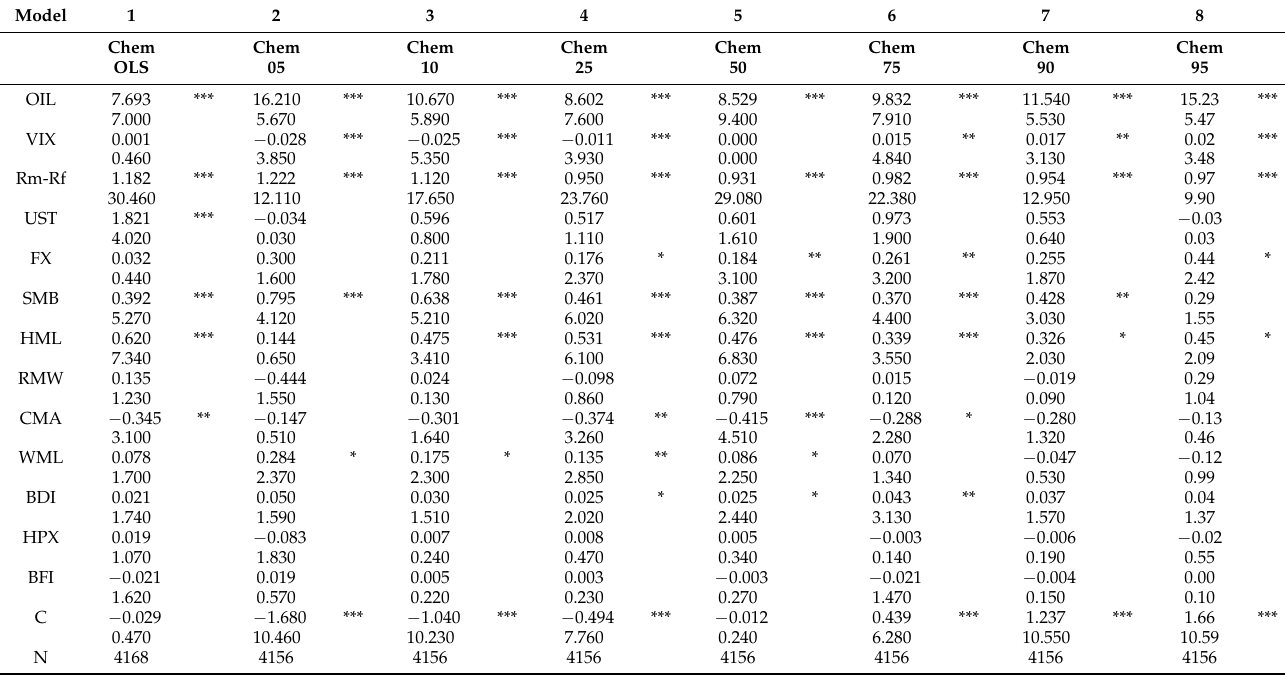
Table 5. Ordinary least square (OLS) and quantile regression estimates for the chemical